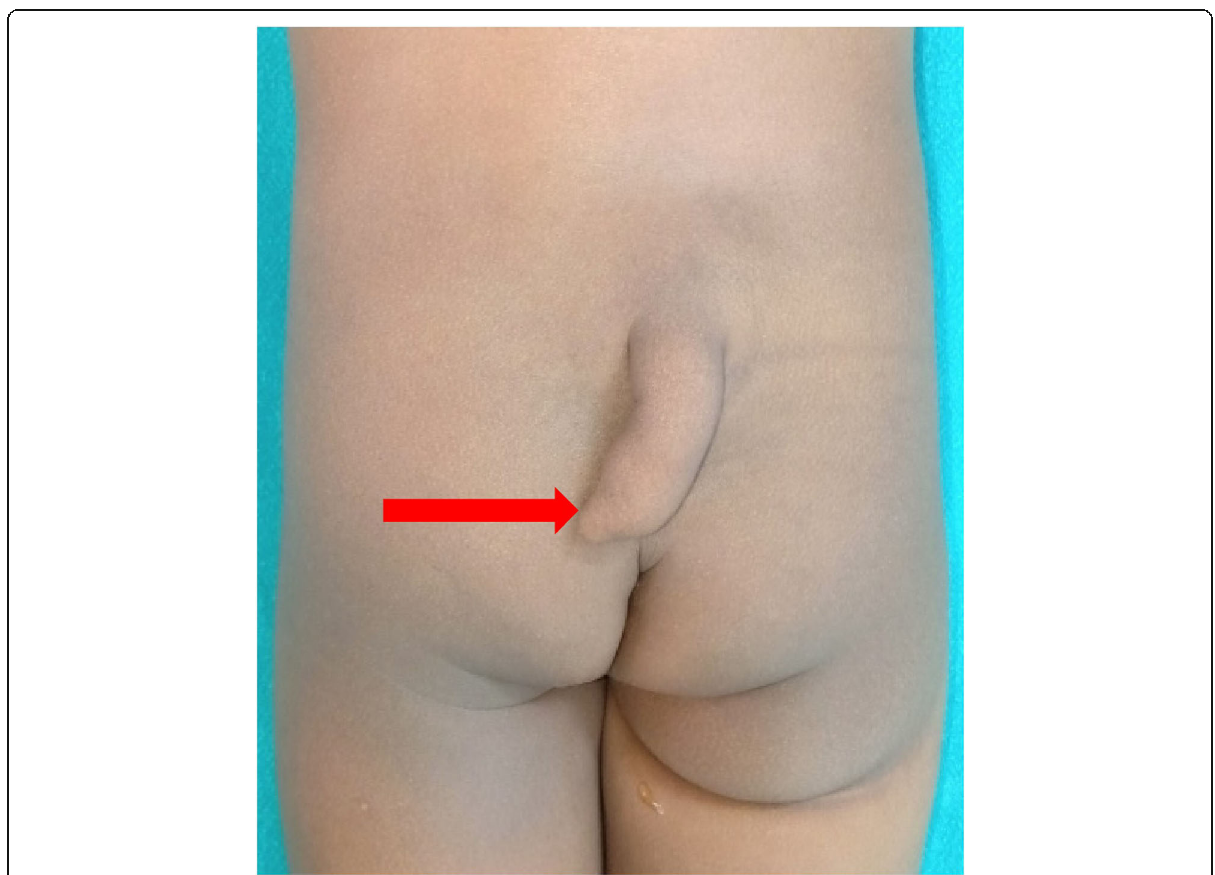
Fig. 1 The appendage (human tail — red arrow) was attached to the back of